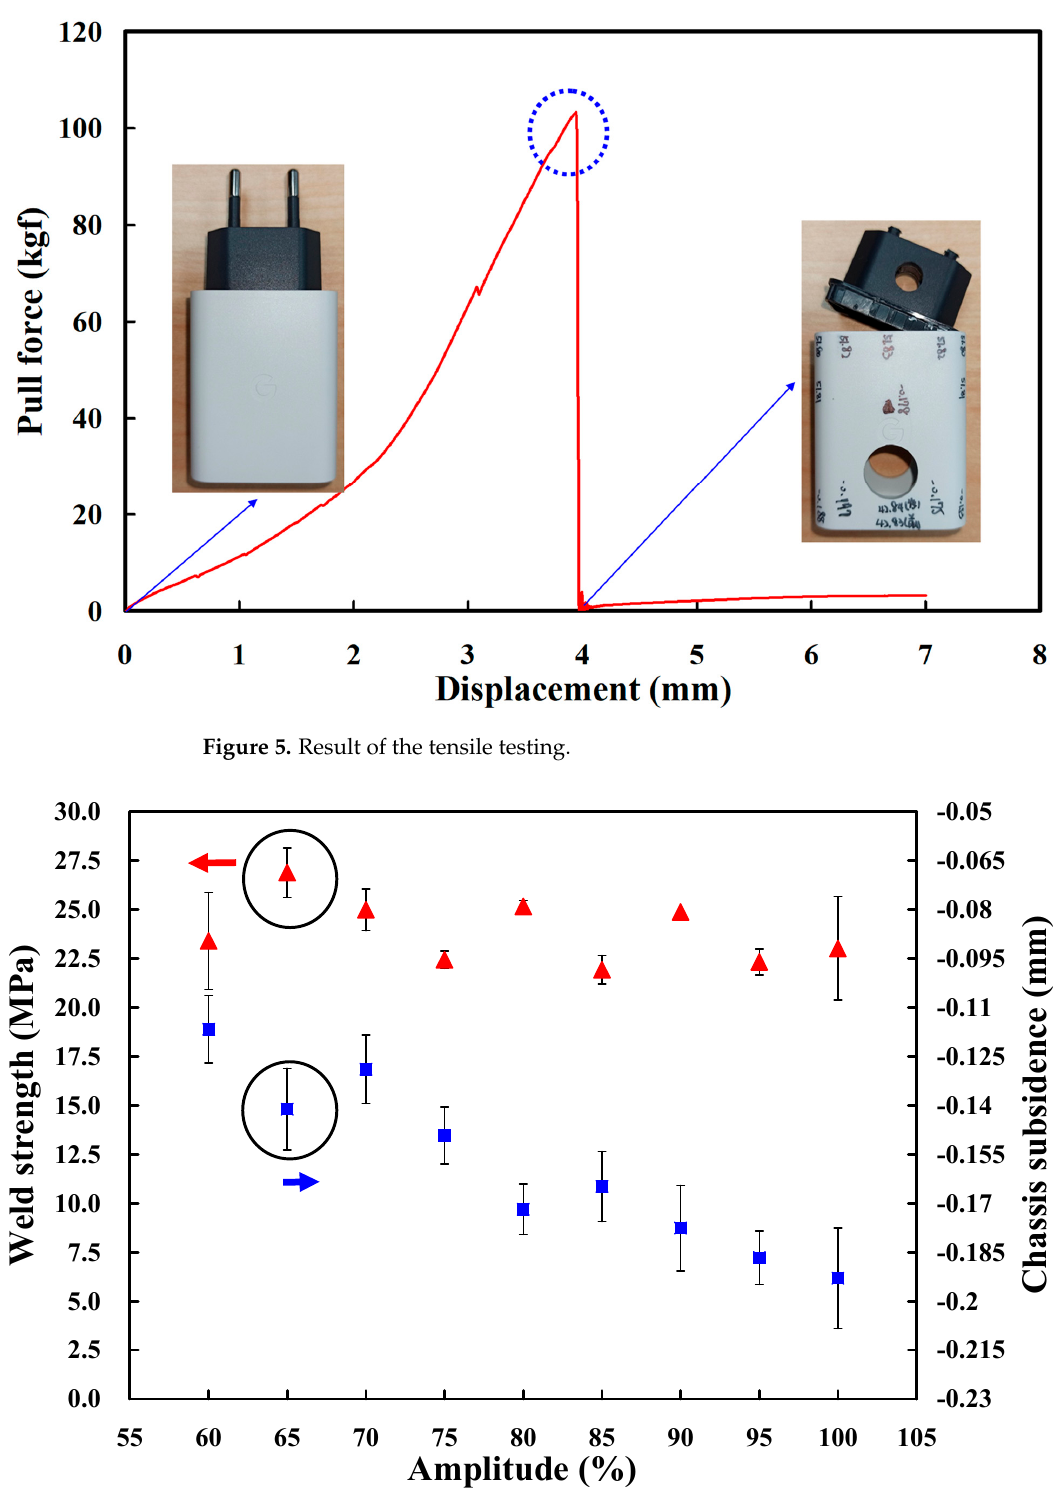
Figure 6. Effects of the different amplitudes on weld strength and chassis subsidence.